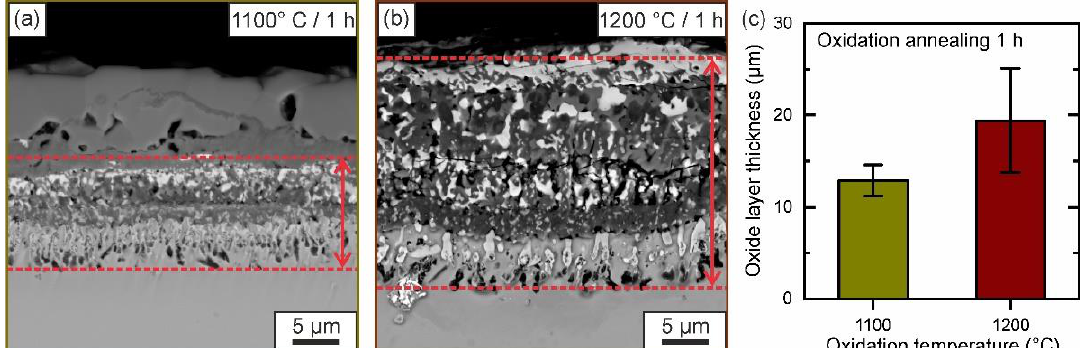
Figure 6. SEM images of the oxide layer after annealing at ( a ) 1100 °C/1 h and ( b ) 1200 °C/1 h. ( c ) Thickness of the inner oxide layer and the interlayer at different oxidation temperatures. The red dashed lines indicate the measured thickness of the inner oxide layer. The outer oxide layer was not included in the measurement due to severe spallation after annealing at 1200 °C for 1 h.